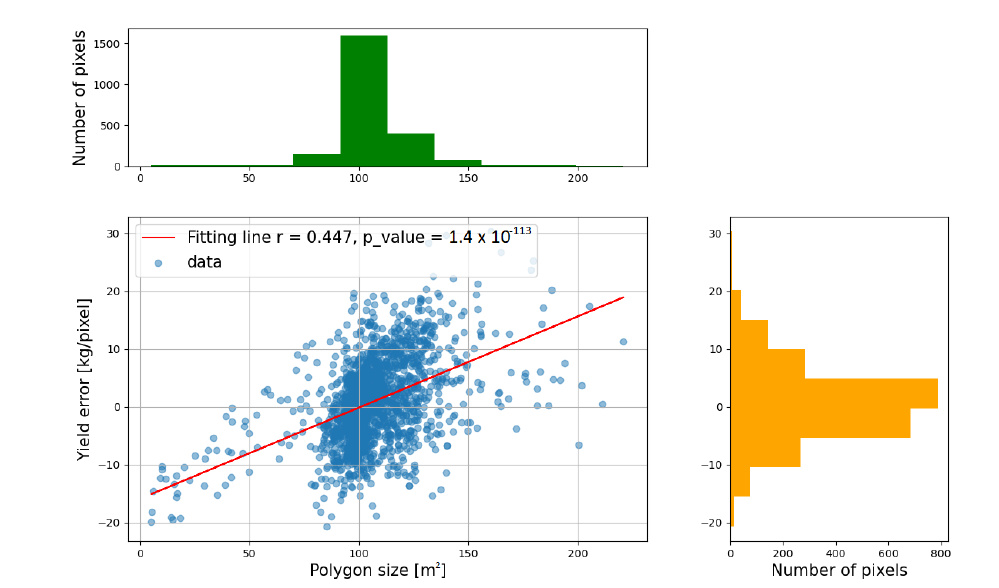
Figure 10. Graph visualization of dependence between yield prediction and overlap area per pixel.